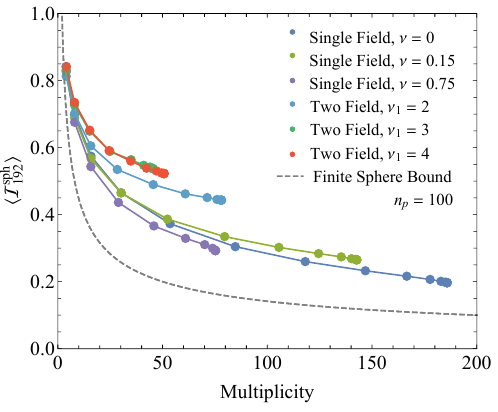
Figure 14 . The average multiplicity vs. average event isotropy at each step in the cascade decays for the single field samples and two field